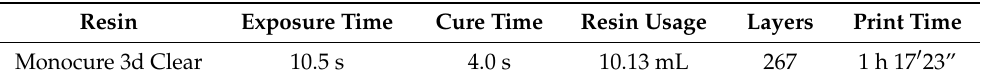
Table 1. Process parameters.